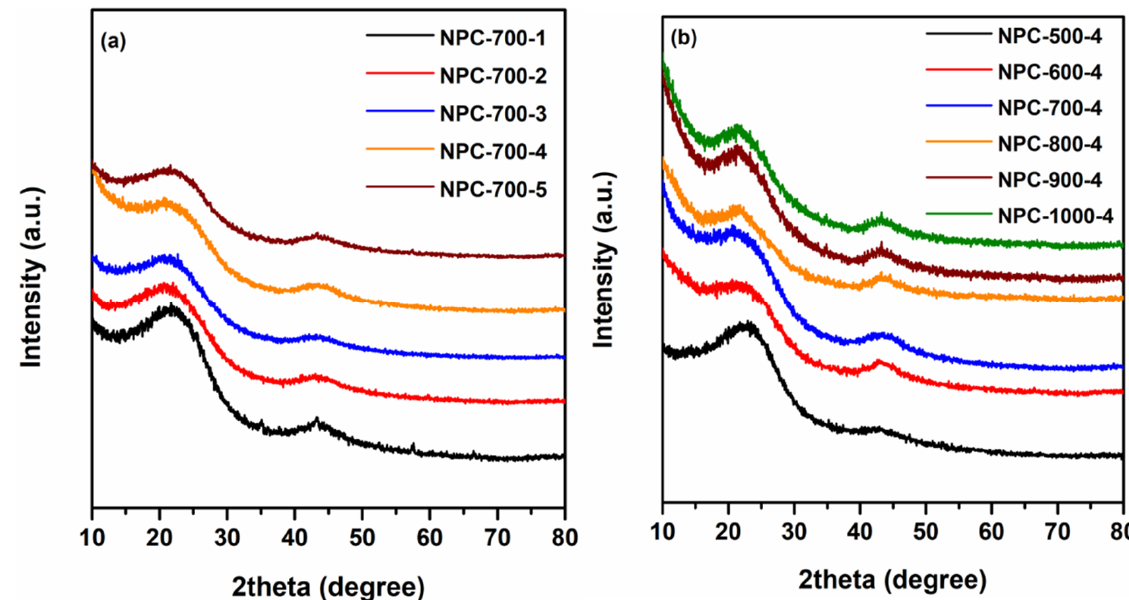
Figure 5. X-ray diffraction patterns of NPC-700-x ( a ) and NPC-y-4 ( b ). Figures 6 and S4 display the Raman spectra of NPC-700-x and NPC-y-4. Two charac- teristic peaks at around 1596 cm −1 (G band) and 1320 cm −1 (D band) are associated with the E2g model of the graphite layer and the vibrations of carbons with dangling bonds, re- spectively [42]. The intensity ratio of the D band and G band (I D /I G ) is indicative of the defects and disorder degree of the carbon materials. The I D /I G values of NPC-700-x and NPC-y-4 exceed or reach 1.0 (Table S1), suggesting the amorphous carbon structure with a high content of lattice edges or defects [43]. Additionally, the I D /I G ratios of NPC-y-4 decrease with the activation temperature (from 1.23 to 0.97), showing that a higher acti- vation temperature can promote the degree of graphitization of the NPCs.